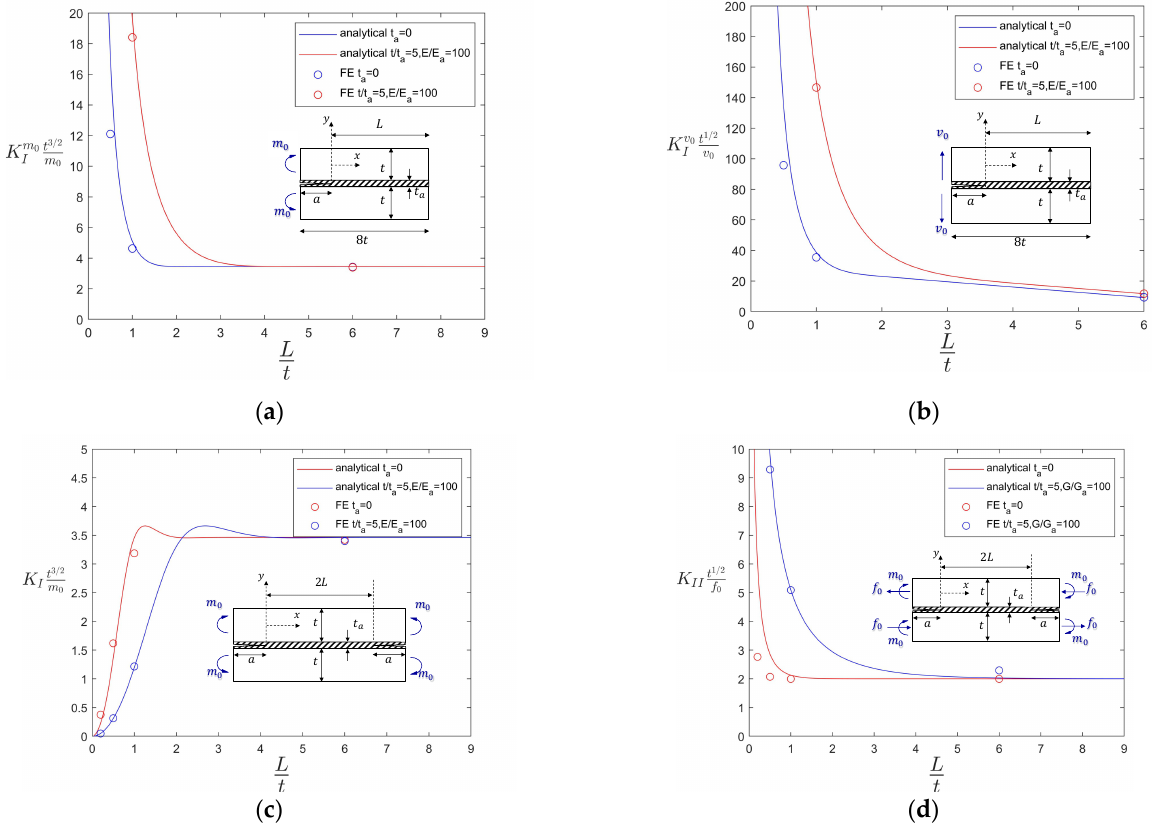
Figure 7. The normalized stress intensity factor as a function of L / t : analytical versus FE validation results. ( a ) Case 1 with moment m 0 on one side. ( b ) Case 1 with transverse load v 0 on one side. ( c ) Case 2 with moment m 0 on two sides. ( d ) Case 3 with both moment m 0 and tension force f 0 on two sides.